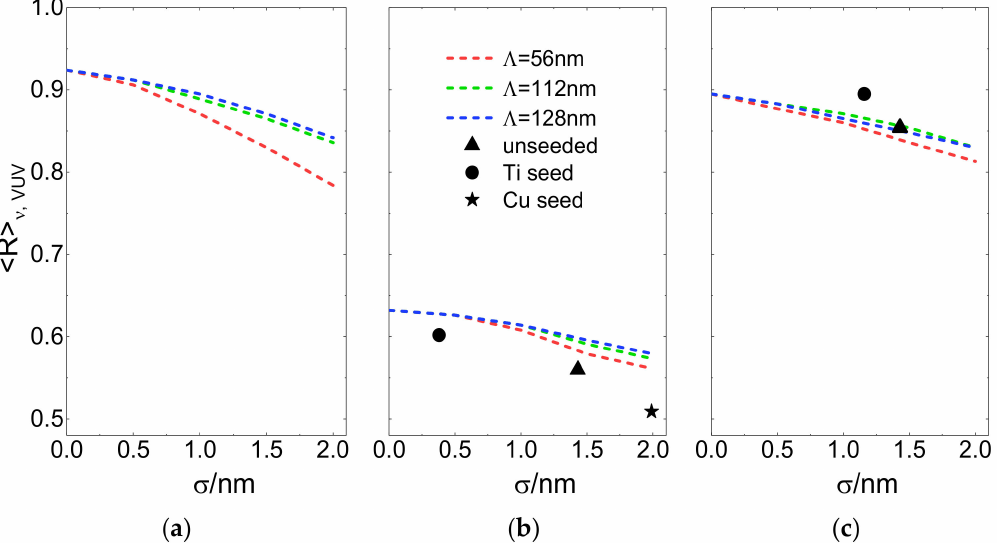
Figure 11. Comparison between average VUV reflectance data. Dashed lines represent calculated dependencies and symbols experimental data. Details see text. ( a ) pure aluminum, ( b ) unprotected aluminum, and ( c ) protected